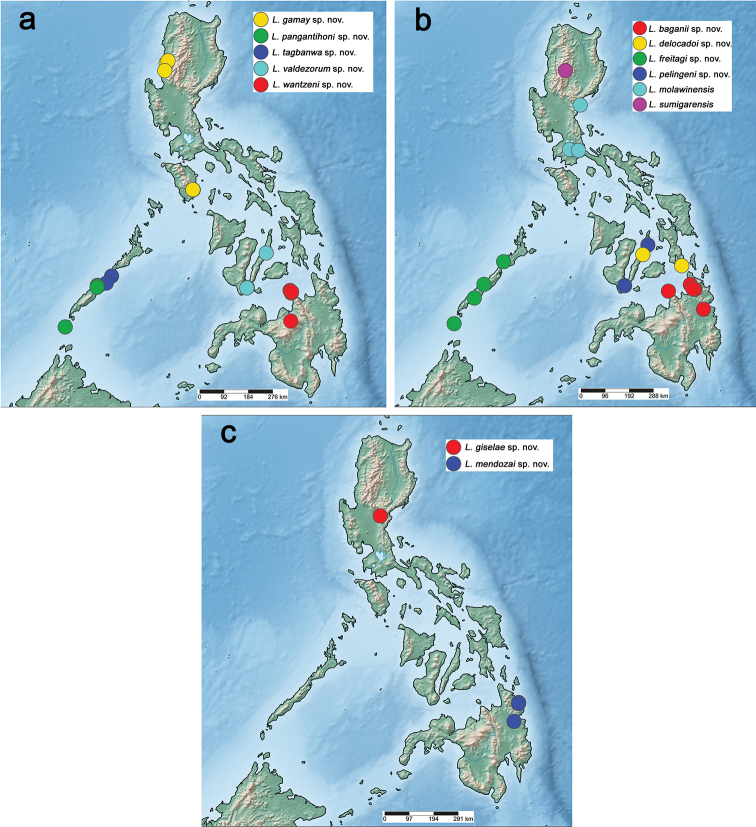
Distribution of Labiobaetis in the Philippines a Group operosusb Group sumigarensisc Group vallus.